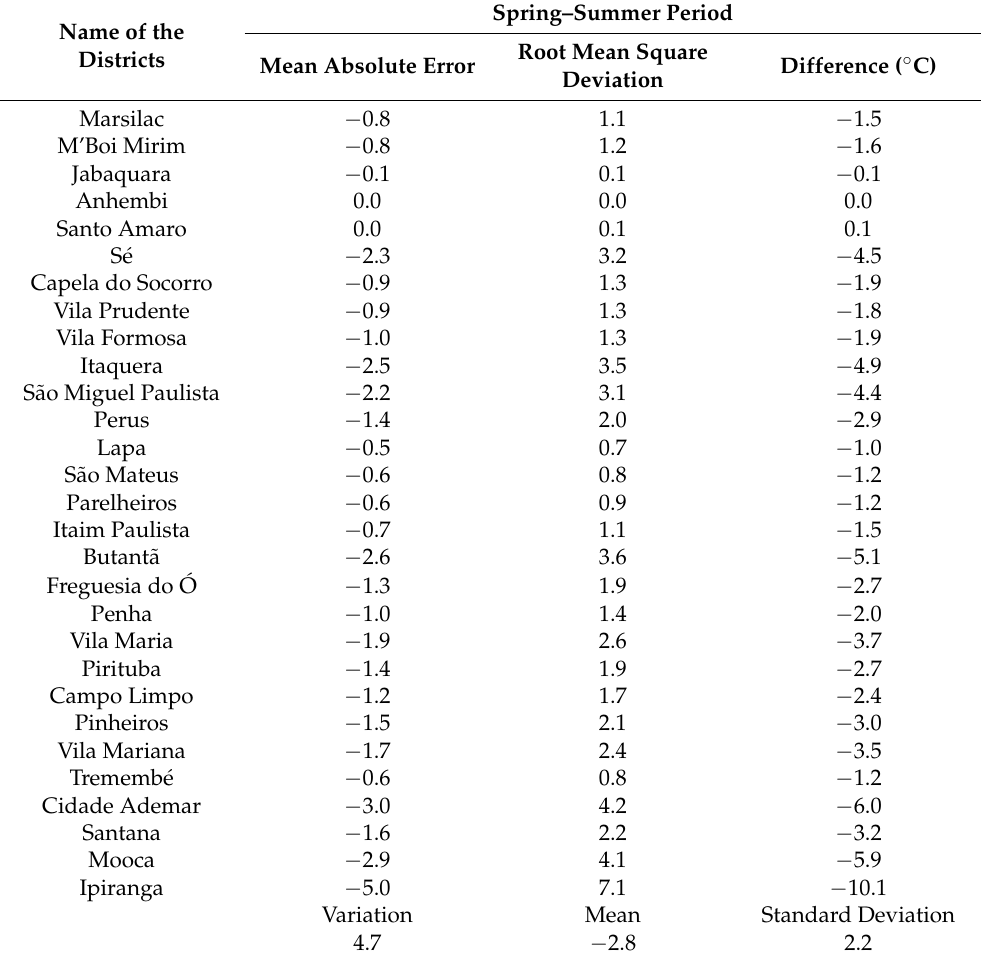
Table 3. Values of the mean absolute error (MAE) and root mean square deviation (RMSD) of the temperature estimated by the observed temperature on 21 January 2019 in the spring–summer season. Source: Management Centre of Climate Emergencies of the S ã o Paulo City,